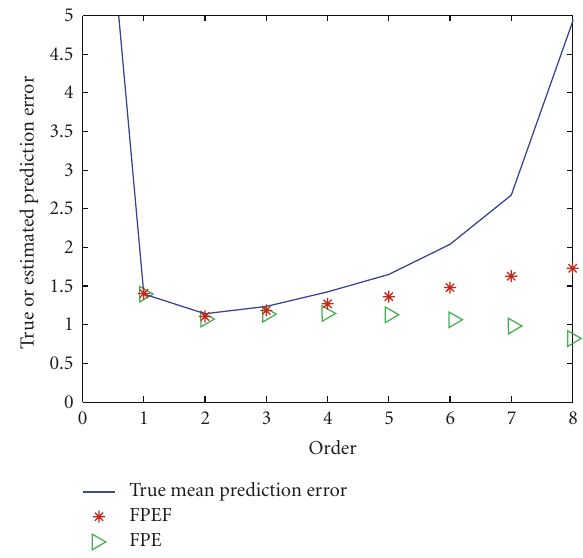
Figure 1: Estimation of prediction error for simulated AR(0) sequence with N = 19.